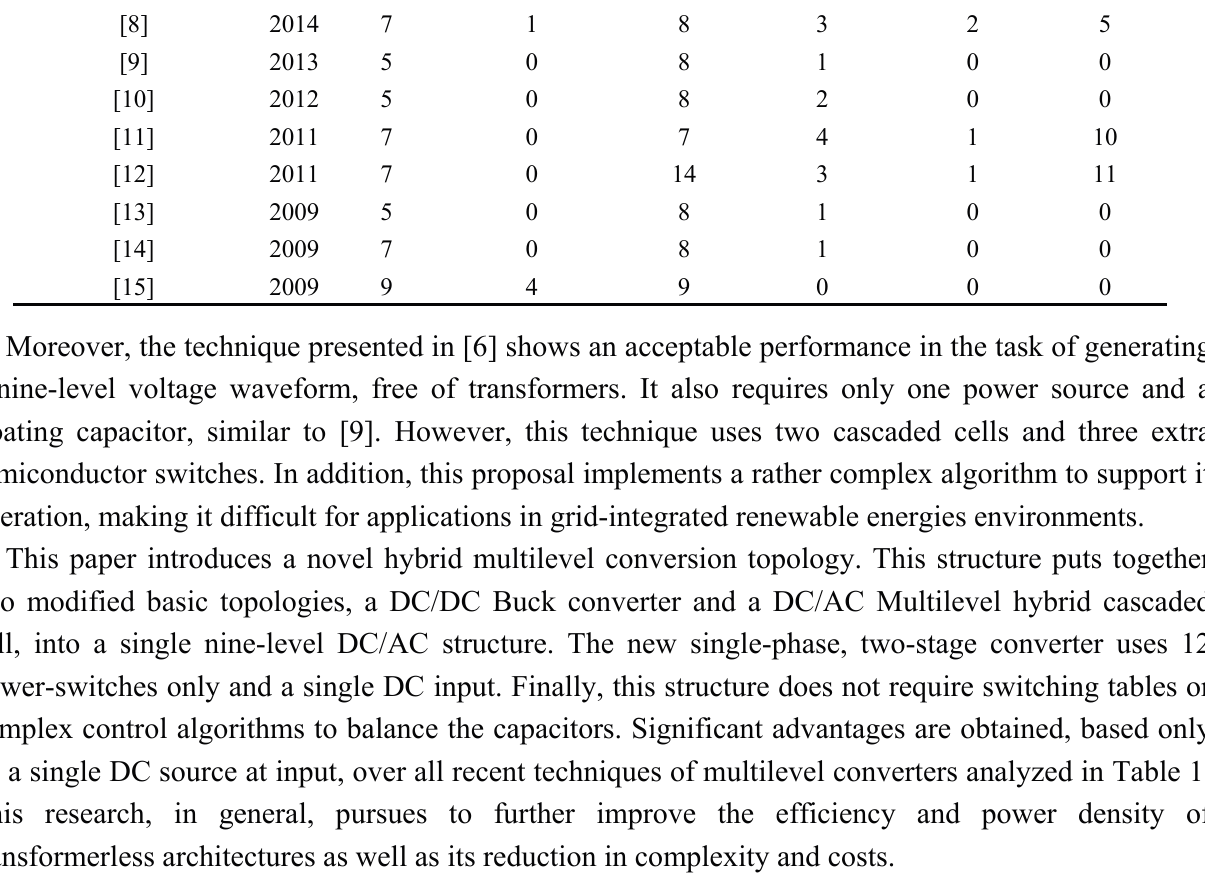
Table 1. Comparison for recent proposal DC/AC multilevel converters based on single DC source. Publications Year Proposed Topology 2014 9 0